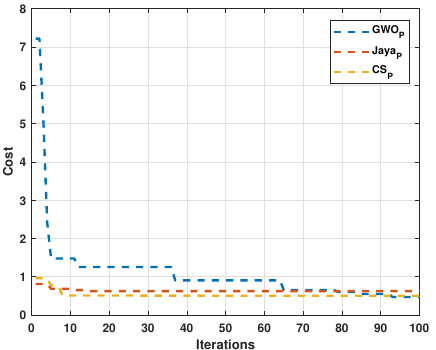
Figure 16. Performance of the proposed algorithms with experimental